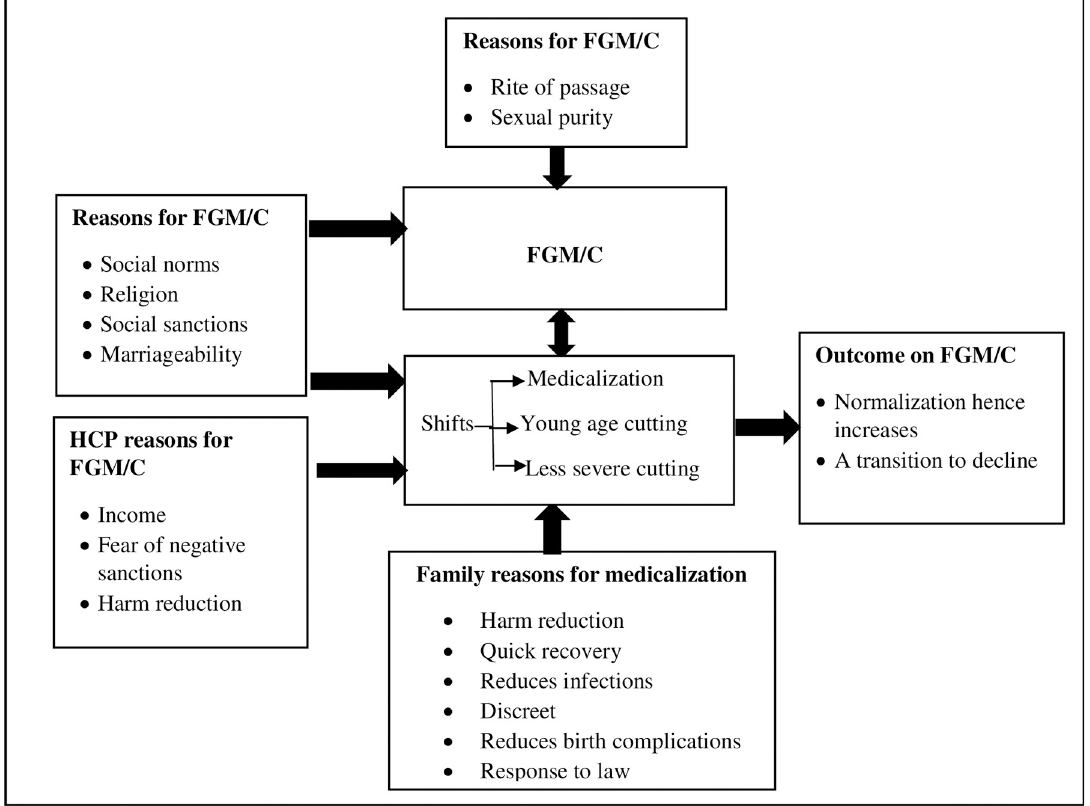
Fig 1. Summary of reasons that perpetuate FGM/C including medicalization in three Kenyan communities. Various reasons perpetuate FGM/C including medicalization among families and health care providers in the Kenyan Communities. Although traditional factors still sustained FGM/C and the related shifts, contemporary practice of FGM/C is perpetuated by new sets of reasons.